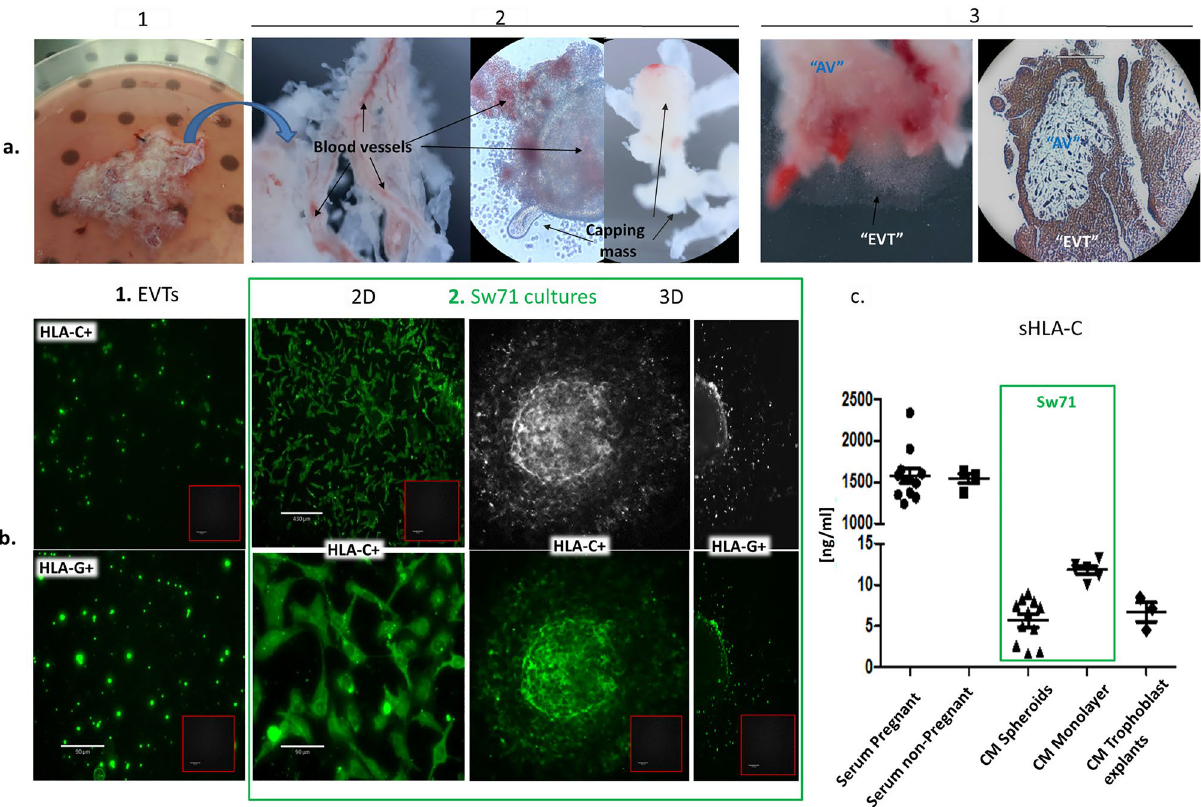
Figure 5. HLA-C expression/production by Sw71 cells, Sw71 spheroids and primary trophoblasts. ( a ) Early placenta-derived trophoblast explants as primary “ex vivo” model of implantation: 1. Trophoblast in a petri dish to be cut into small explants; 2. Trophoblast explants cultured in hsDMEM/F12 with signs for vitality—blood vessels, formation of capping mass, expansion of EVTs; 3. Vital, attached trophoblast explants with expanding EVTs (left) resembling anchoring chorionic villa with trophoblast column on the tips, containing EVTs (right, paraffin slide). The EVTs within the trophoblast column are HLA-C-positive (brown). ( b ) Immunocytochemical staining for HLA-C and HLA-G: 1. Explants-derived EVTs expressed HLA-C (up) and HLA-G (down); 2. Sw71 cultures: HLA-C + Sw71 cells in monolayer (2D) and migrating Sw71-GFP spheroids positive for both markers HLA-C and HLA-G (3D, left and right columns, respectively). The spheroids were captured in brightfield and fluorescence mode. Inserts in ( b )—negative controls for the immunofluorescent staining where the primary antibody was omitted. ( c ) sHLA-C in CM and sera, measured by ELISA. Imaging: Echo Revolve microscope (Echo, San Diego, CA, USA), magnification 4× ( a ) and 20× ( b